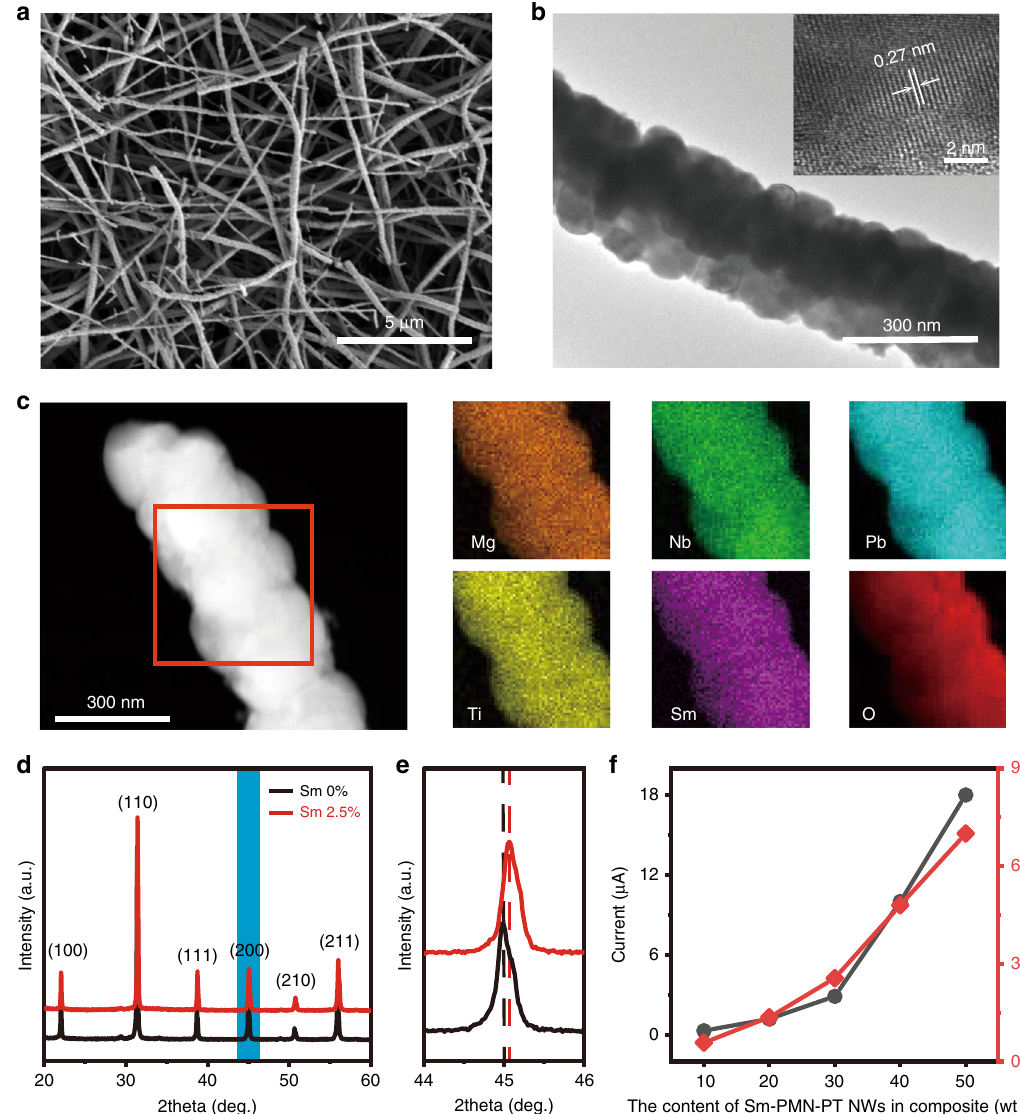
Fig. 1 Characterization of Sm-PMN-PT NWs. a SEM image of annealed Sm-PMN-PT NWs. b Low magni fi cation dark fi eld image of a NW and inserted higher-magni fi cation HRTEM image. c EDS mapping of a Sm-PMN-PT NW with uniform distribution of Mg, Nb, Pb, Ti, Sm and O in the NW. d XRD patterns of Sm doped (red) and undoped (black) PMN-PT NWs. e An enlarged view of the diffraction peaks around 45° marked by blue in d . f Output performance of PENGs with different content of Sm-PMN-PT NWs in the